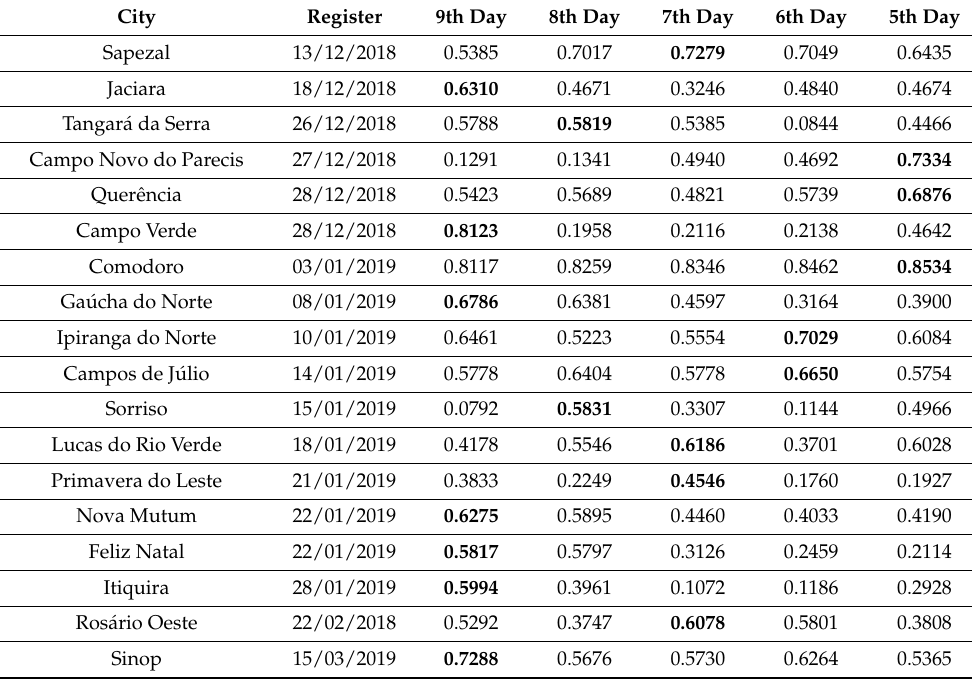
Table 4. Favorability data for ASR occurrence.